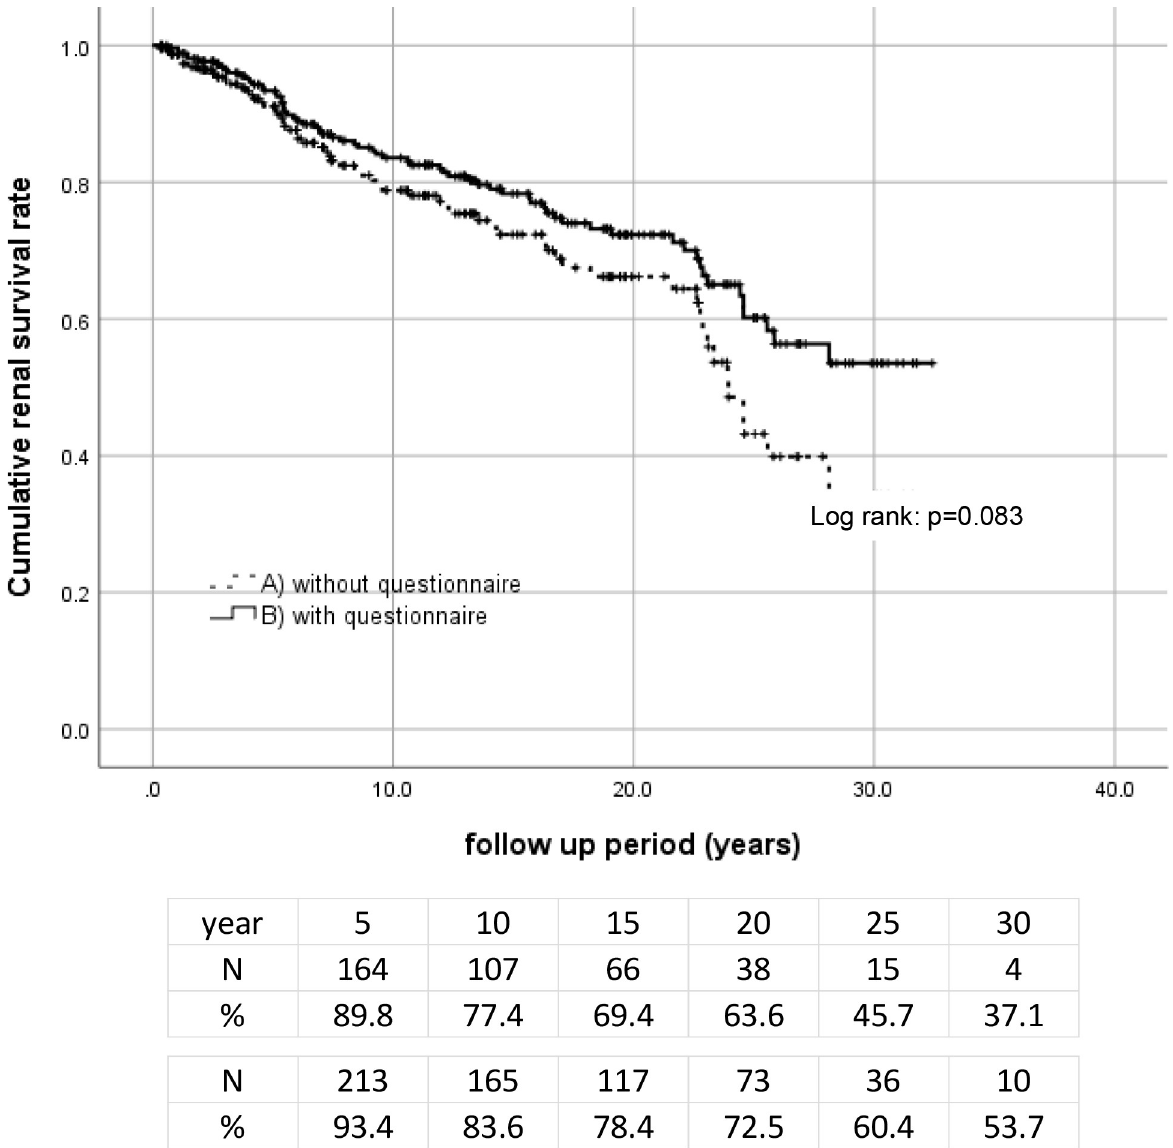
Fig 2. The patient’s cumulative renal survival. (A)The Kaplan-Meier curve was made using our hospital’s medical records. (B)The Kaplan-Meier curve was made from combined data adding the questionnaire results. The number of patients remaining at 5, 10, 15, and 20 years of follow-up are shown at the